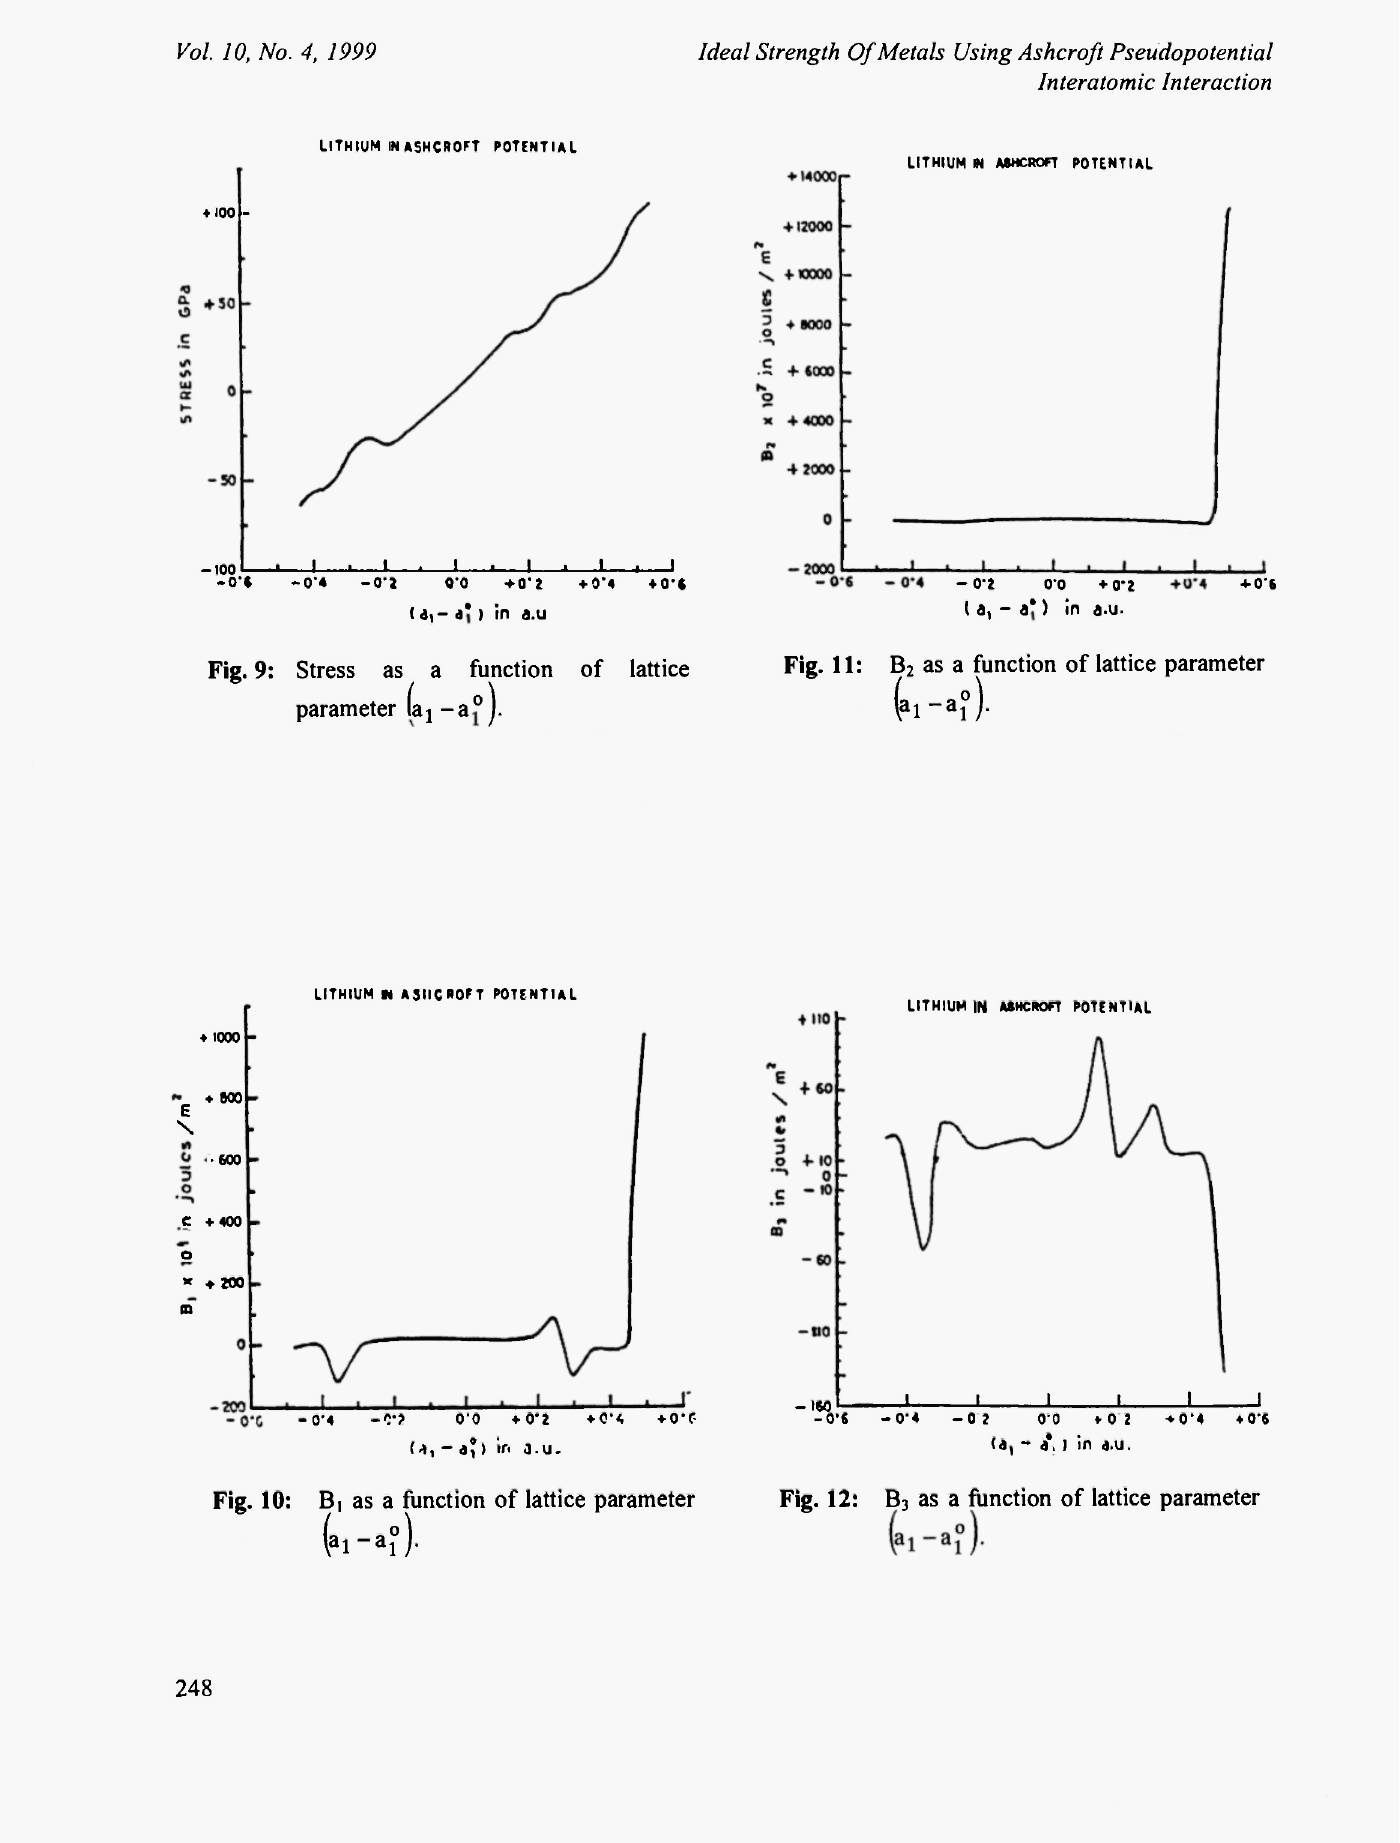
Fig. 11: B 2 as a function of lattice parameter (ai-a?)-